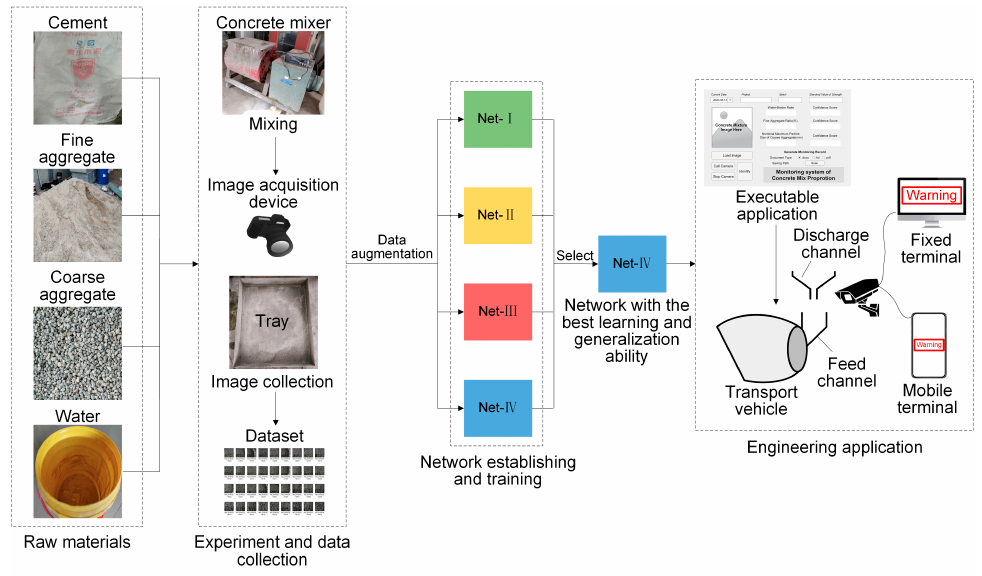
Figure 10. Working flow and research process of the present study.